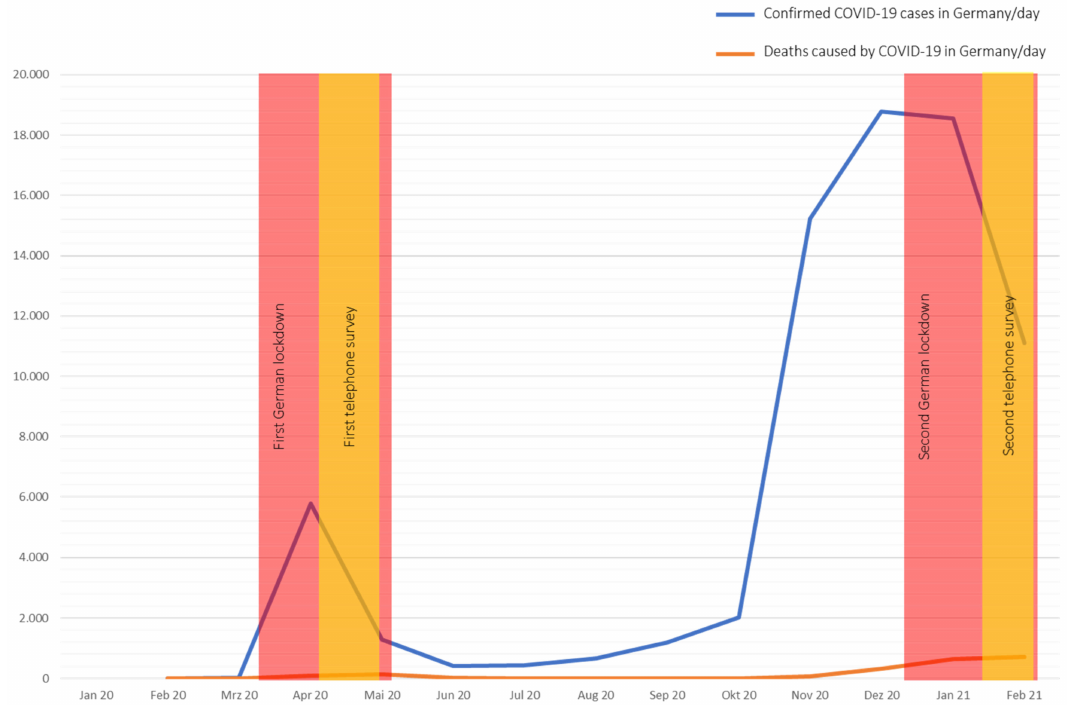
Figure 1. Course of the COVID-19 Pandemic in Germany. (Data are extracted from OurWorldInData.org [5], access date: 28 February